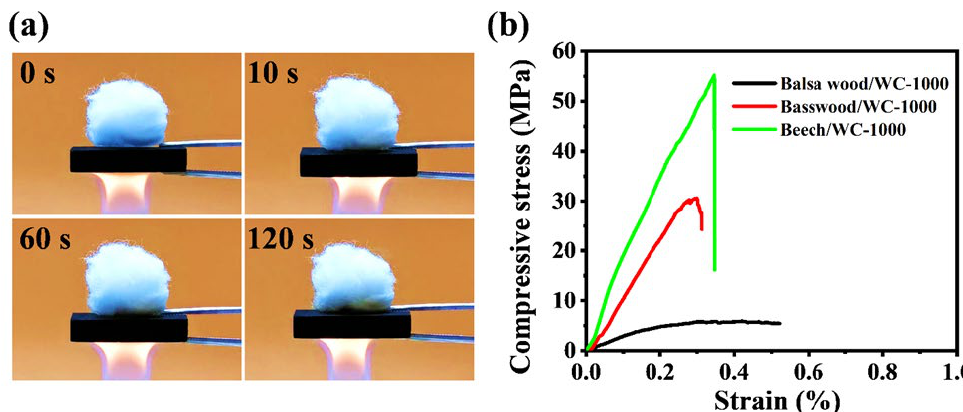
Figure 8. ( a ) Photos of basswood-derived carbon after combustion. ( b ) Compressive stress–strain curves of WC-1000 (balsa wood, basswood and beech).